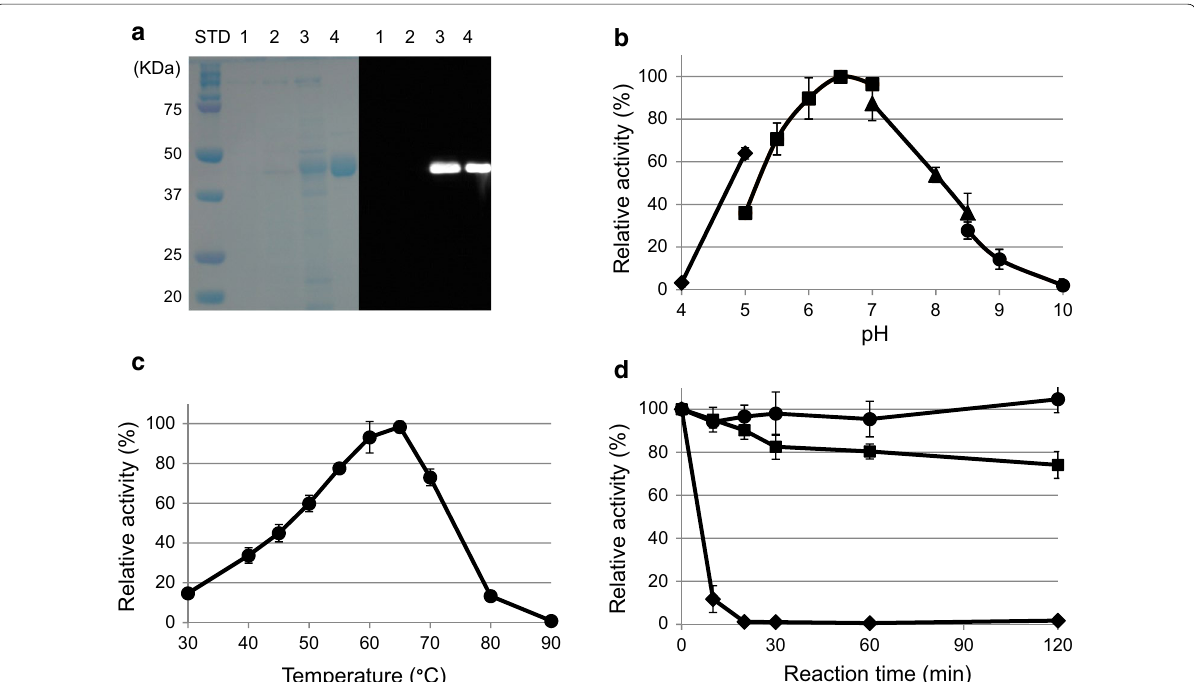
Fig. 4 a SDS‑PAGE and western blotting of recombinant β‑mannanase (ManKs_4‑555) expressed in S. lividans 1326; STD, molecular weight marker; lane 1 , culture supernatant from S. lividans 1326 (wild type); lane 2 , culture supernatant from S. lividans 1326/pUC702‑pro; lane 3 , culture supernatant from S. lividans 1326/pUC702‑pro‑ManKs‑(His) 6 before purification; lane 4 , purified β‑mannanase (ManKs_4‑555). b Effect of pH on β‑mannanase activity of ManKs_4‑555 containing 0.5% (w/v) LBG. Activity was measured at 45 °C using the following buffers: acetate buffer (pH 4.0–5.0, filled dia- mond ), MES buffer (pH 5.0–7.0, filled square ), MOPS buffer (pH 7.0–8.5, filled triangle ), and glycine–NaOH buffer (pH 8.5–10, filled circle ). ManKs_4‑555